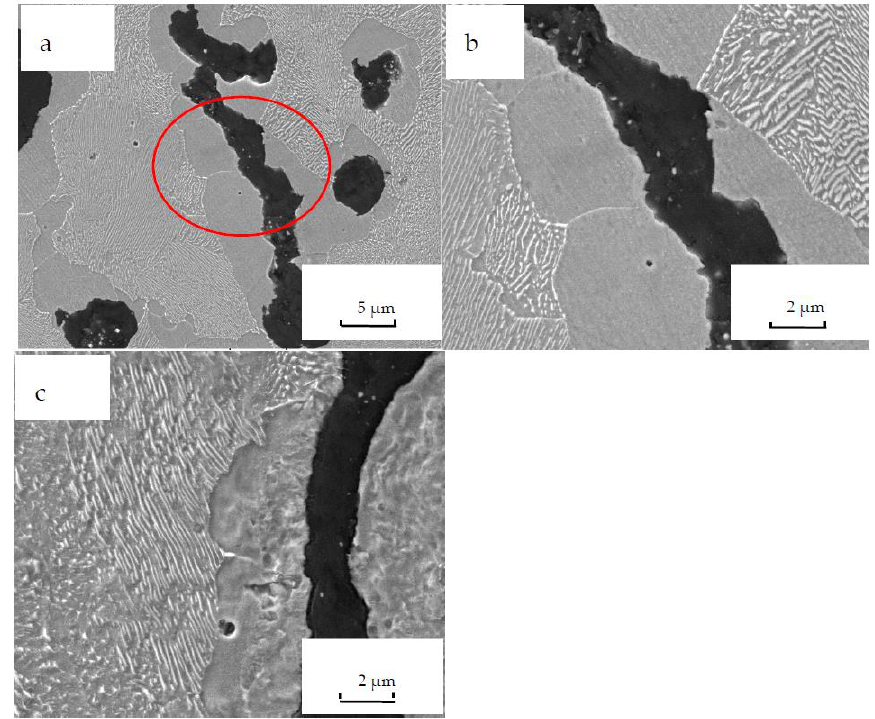
Figure 6. Microstructures of vermicular iron (with etching) ( a ) oxidation for 0 h, 2000 × , ( b ) oxidation for 0 h, 5000 × , and ( c ) oxidation for 500 h, 5000 ×.